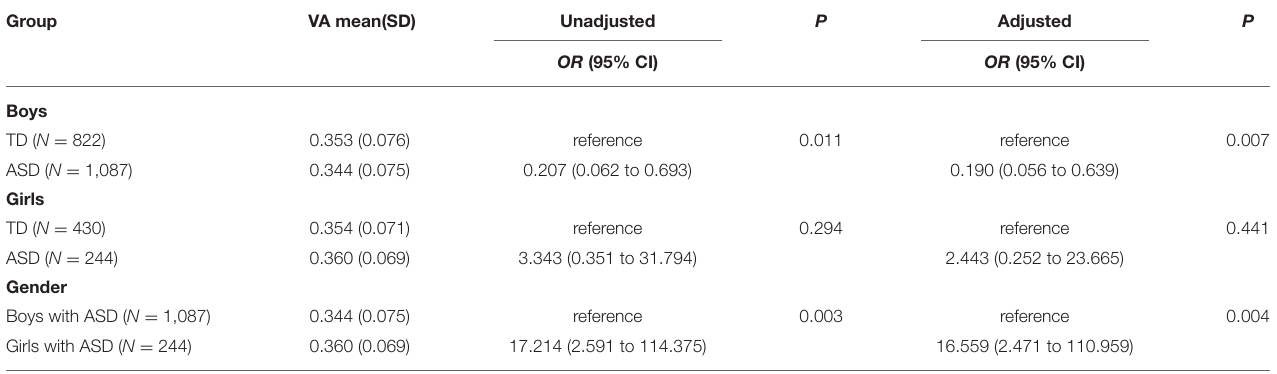
TABLE 3 | Comparison of the levels of serum VA between children with ASD and TD in different gender. Group VA mean(SD) Unadjusted P Adjusted P OR (95% CI) OR (95% CI)